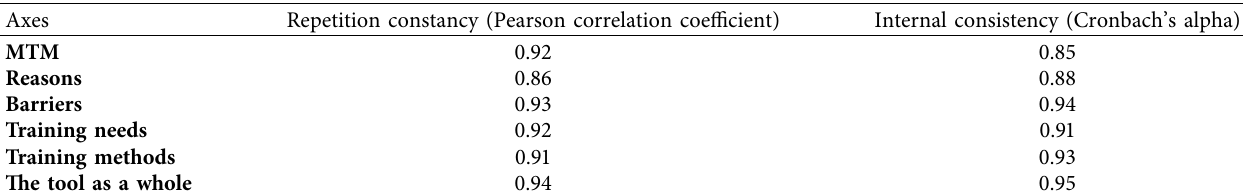
Table 3: The correlation coefficient values between the questionnaire’s axes to each other and the tool as a whole. Axes MTM Reasons Barriers Training needs Training methods The tool as a whole MTM 1.0 0.87 ∗∗ 0.88 ∗∗ Reasons 1.0 Barriers